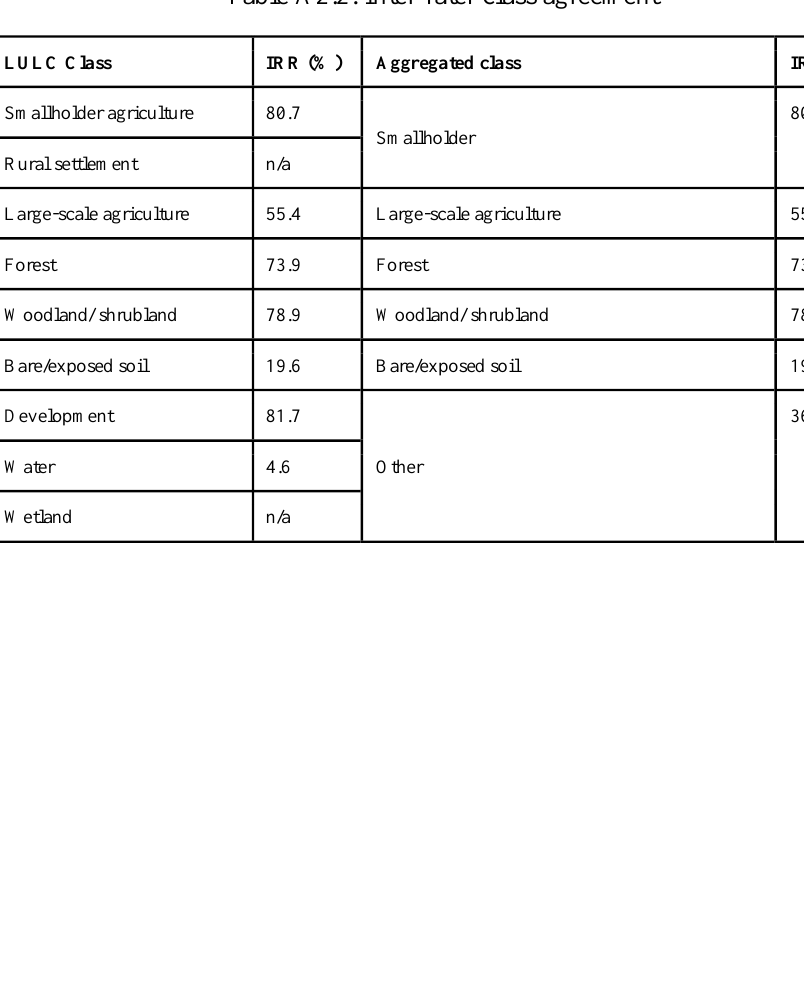
Table A2.2: Inter-rater class